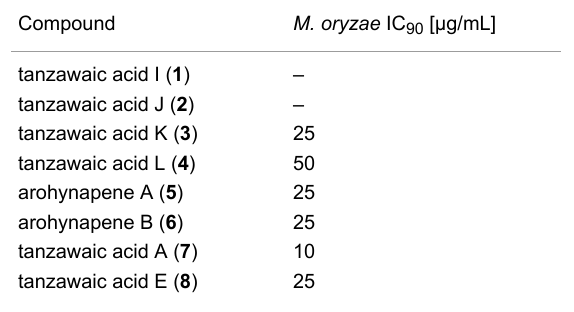
Table 3: Inhibition of germination in Magnaporthe oryzae (IC 90 repre- sents the concentration at which 90% inhibition of conidial germination was